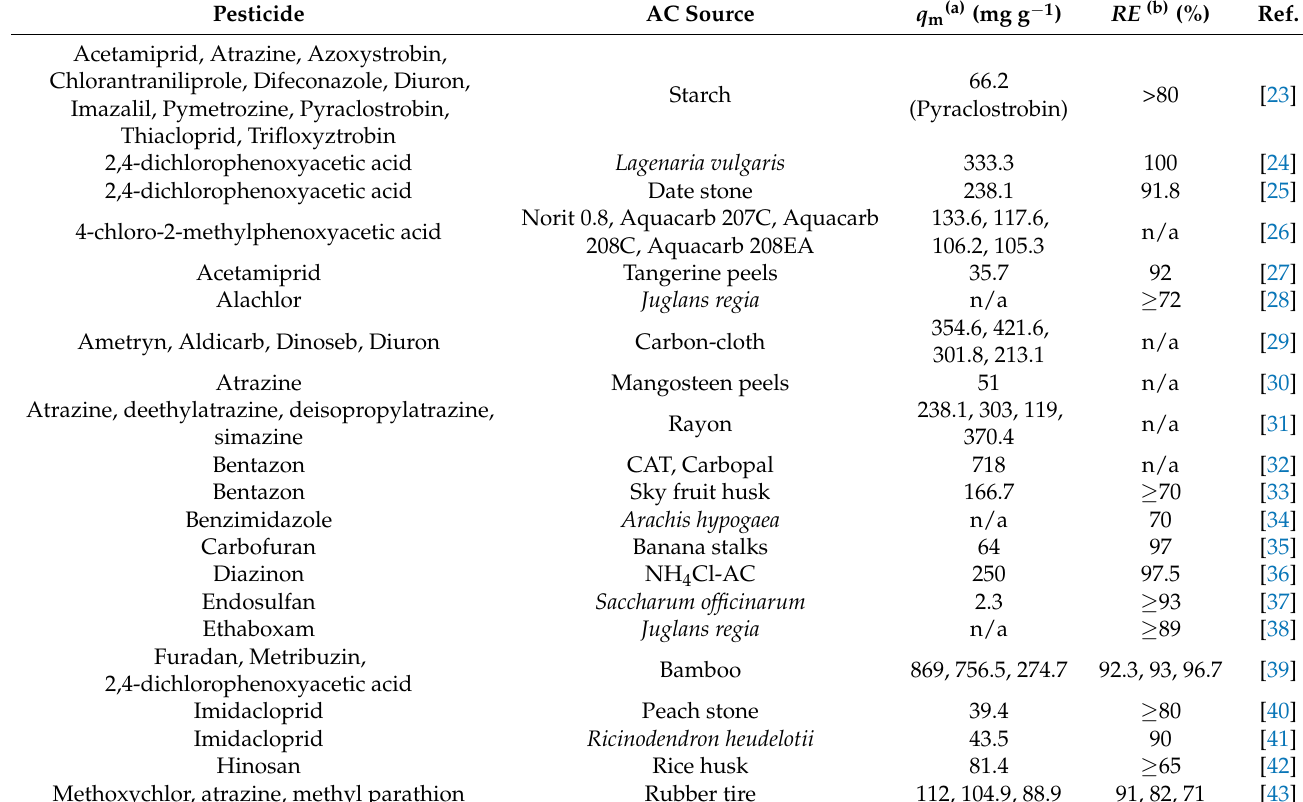
Table 1. Sorption efficiency of pesticides from activated carbon